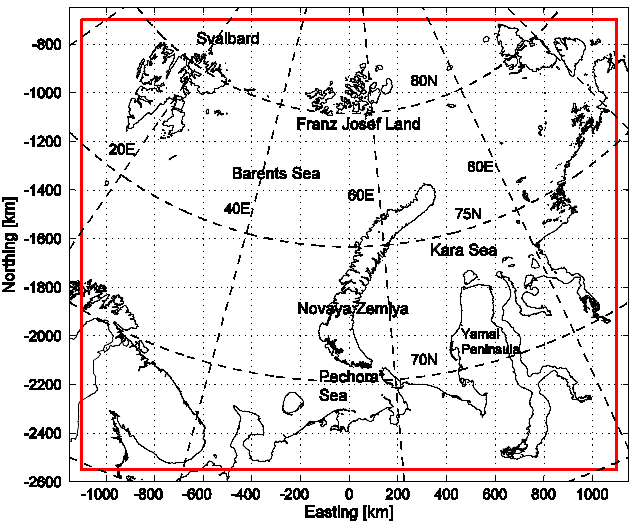
Figure 1. The Barents and Kara Seas study area for the MODIS based daily sea ice thickness and open water–sea ice classification charts. The red rectangle shows the area. The Pechora Sea is part of the Barents Sea.